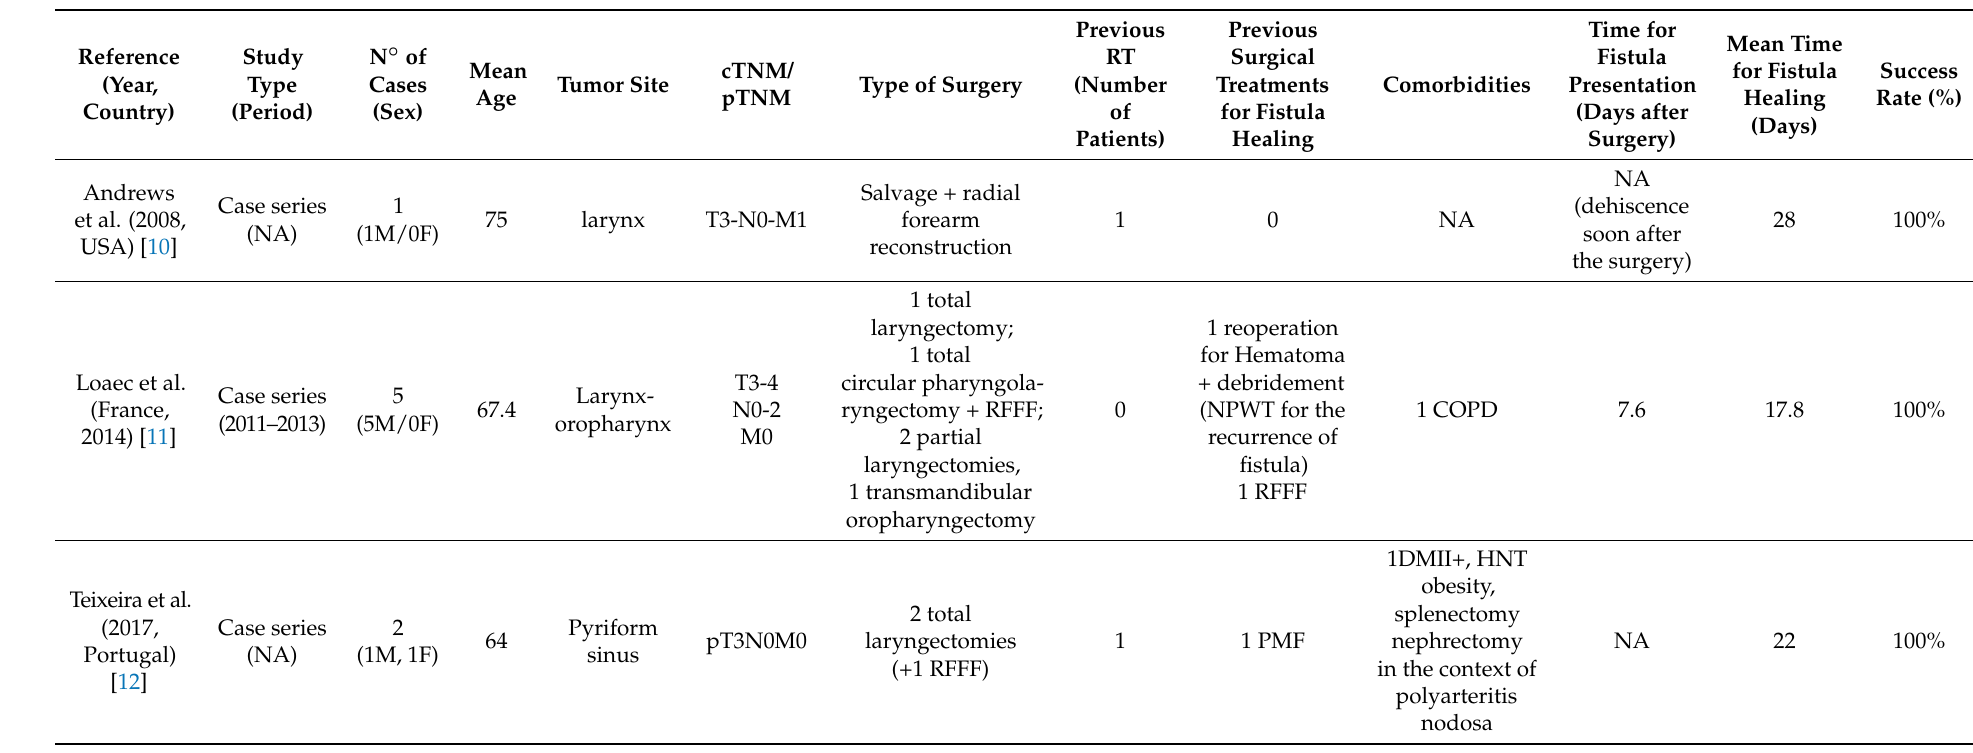
Table 2. Overview of the clinical outcomes of patients treated for PCF using negative pressure wound therapy (NPWT). Acronyms: NA, not available; M,